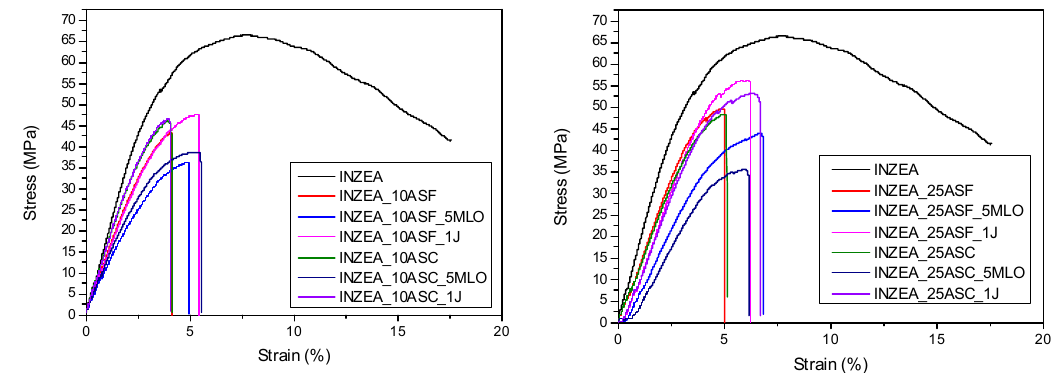
Figure 3. Stress–strain curves of polyester-based biocomposites containing 10 and 25 wt % of ASP at two grinding levels (F, C), with or without compatibilizers.